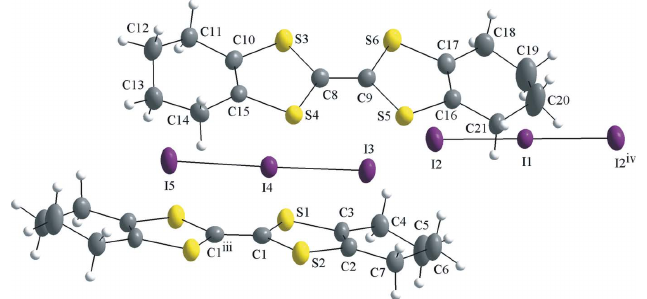
Figure 1 The molecular structure of the title compound, (cid:2) -(OMTTF)I 3 , showing the atom labelling and displacement ellipsoids drawn at the 40% probability level. Symmetry codes: (iii) (cid:3) x + 1, (cid:3) y + 1, (cid:3) z ; (iv) (cid:3) x + 2, (cid:3) y , (cid:3) z +